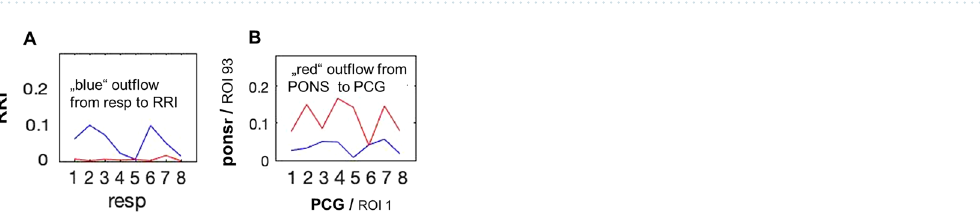
Figure 3. Coupling strength (vertical axis) across 8 time windows (horizontal axis) between RRI and respiratory signal ( A ) for one representative participant in the frequency band of 0.05 to 0.15 Hz; dominant flow from respiration to RRI, characteristic for positive RSA, is documented. Coupling strength between BOLD signals from brainstem rostral pons structure (ponsr, ROI 93) and PCG from another participant ( B